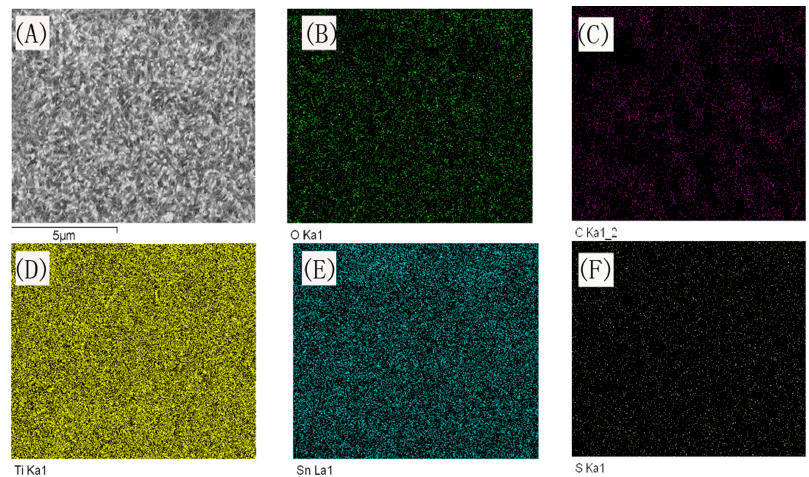
Figure 3. EDS mapping of H-TiO 2 -PEDOT. ( A ) Scanning area, ( B ) O Element, ( C ) C Element, ( D ) Ti Element, ( E ) Sn Element, ( F ) S